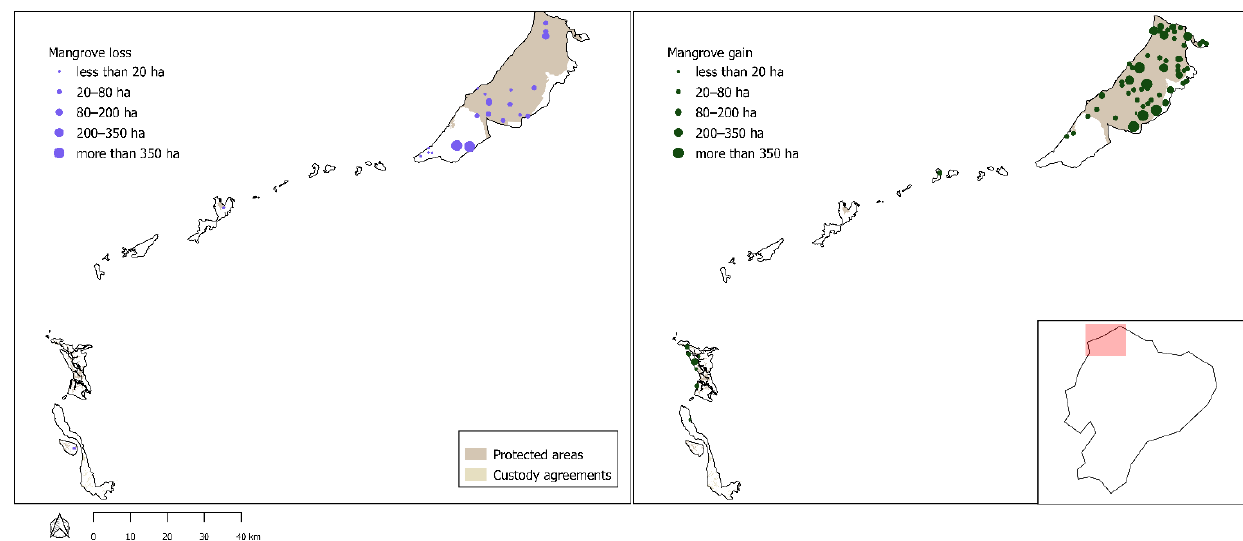
Figure 7. Mangrove losses and gains in the Esmeraldas province between 1998 and 2016.